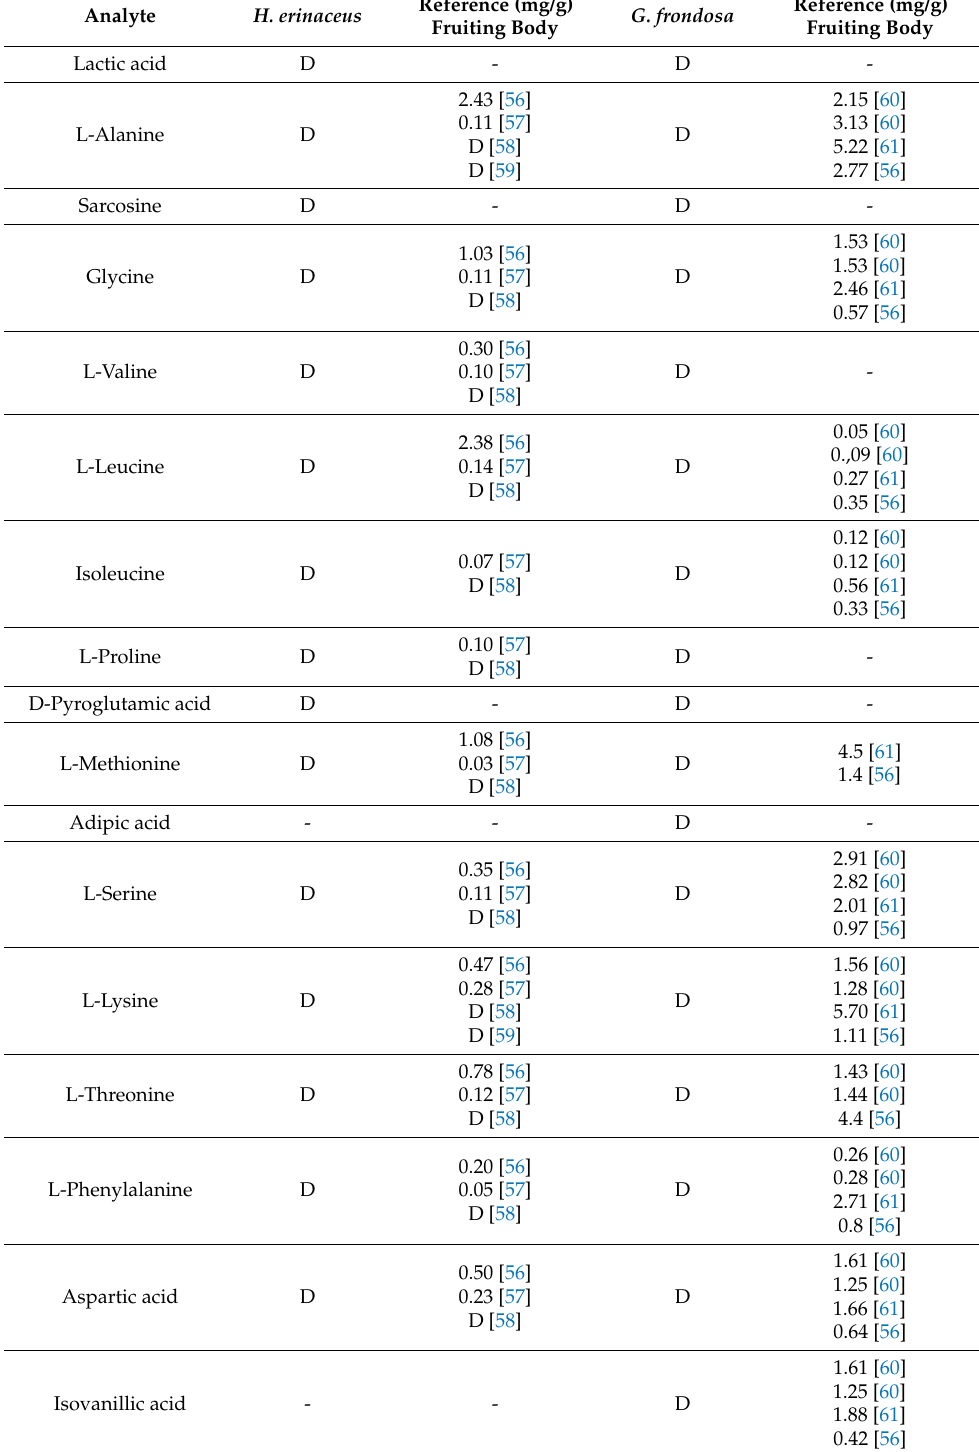
Free amino acids, as well as unsaturated fatty acids, ergosterol, and other compounds were investigated by GC/MS analyses (Supplementary Table S1). Both the samples were good sources of amino acids (including essential ones), as well as of unsaturated fatty acids (Table 1), in agreement with previously reported data (see references in Table 1). Table 1. Analytes identified by GC/MS and comparison with bibliographic references.